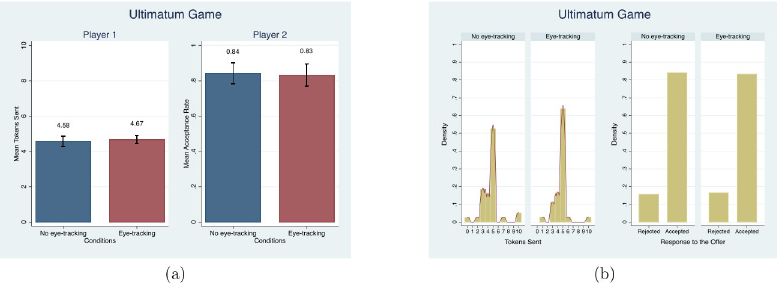
Fig 8. Mean and distribution comparisons in the number of tokens sent and the acceptance of the offer. Note. For player 2, acceptance is coded as 1 and rejection is coded as 0. Red lines in (b) present the univariate kernel density